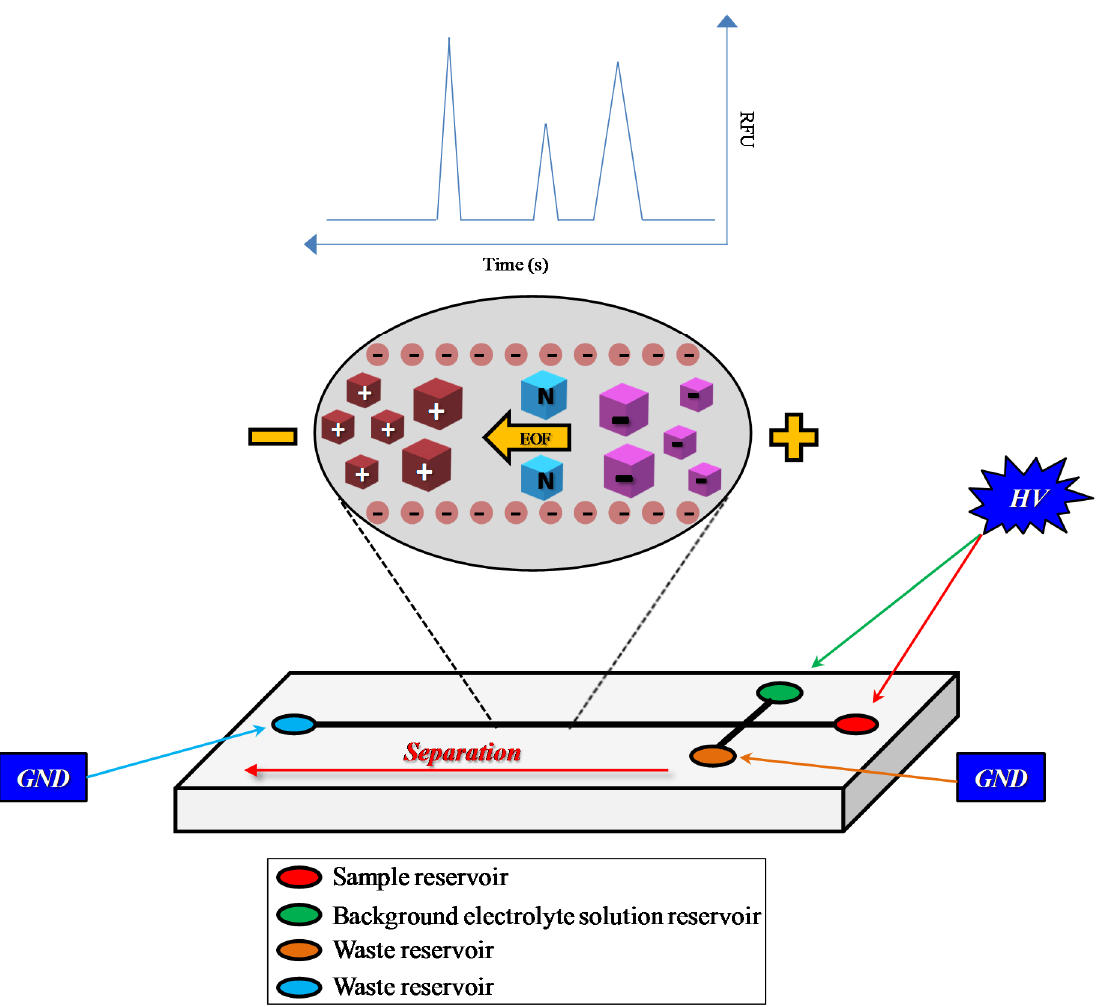
Figure 1. Typical microchip design (simple ‘T’ design) consisting of a separation channel and two side arms. EOF = electroosmotic flow; GND = ground; HV = high voltage.